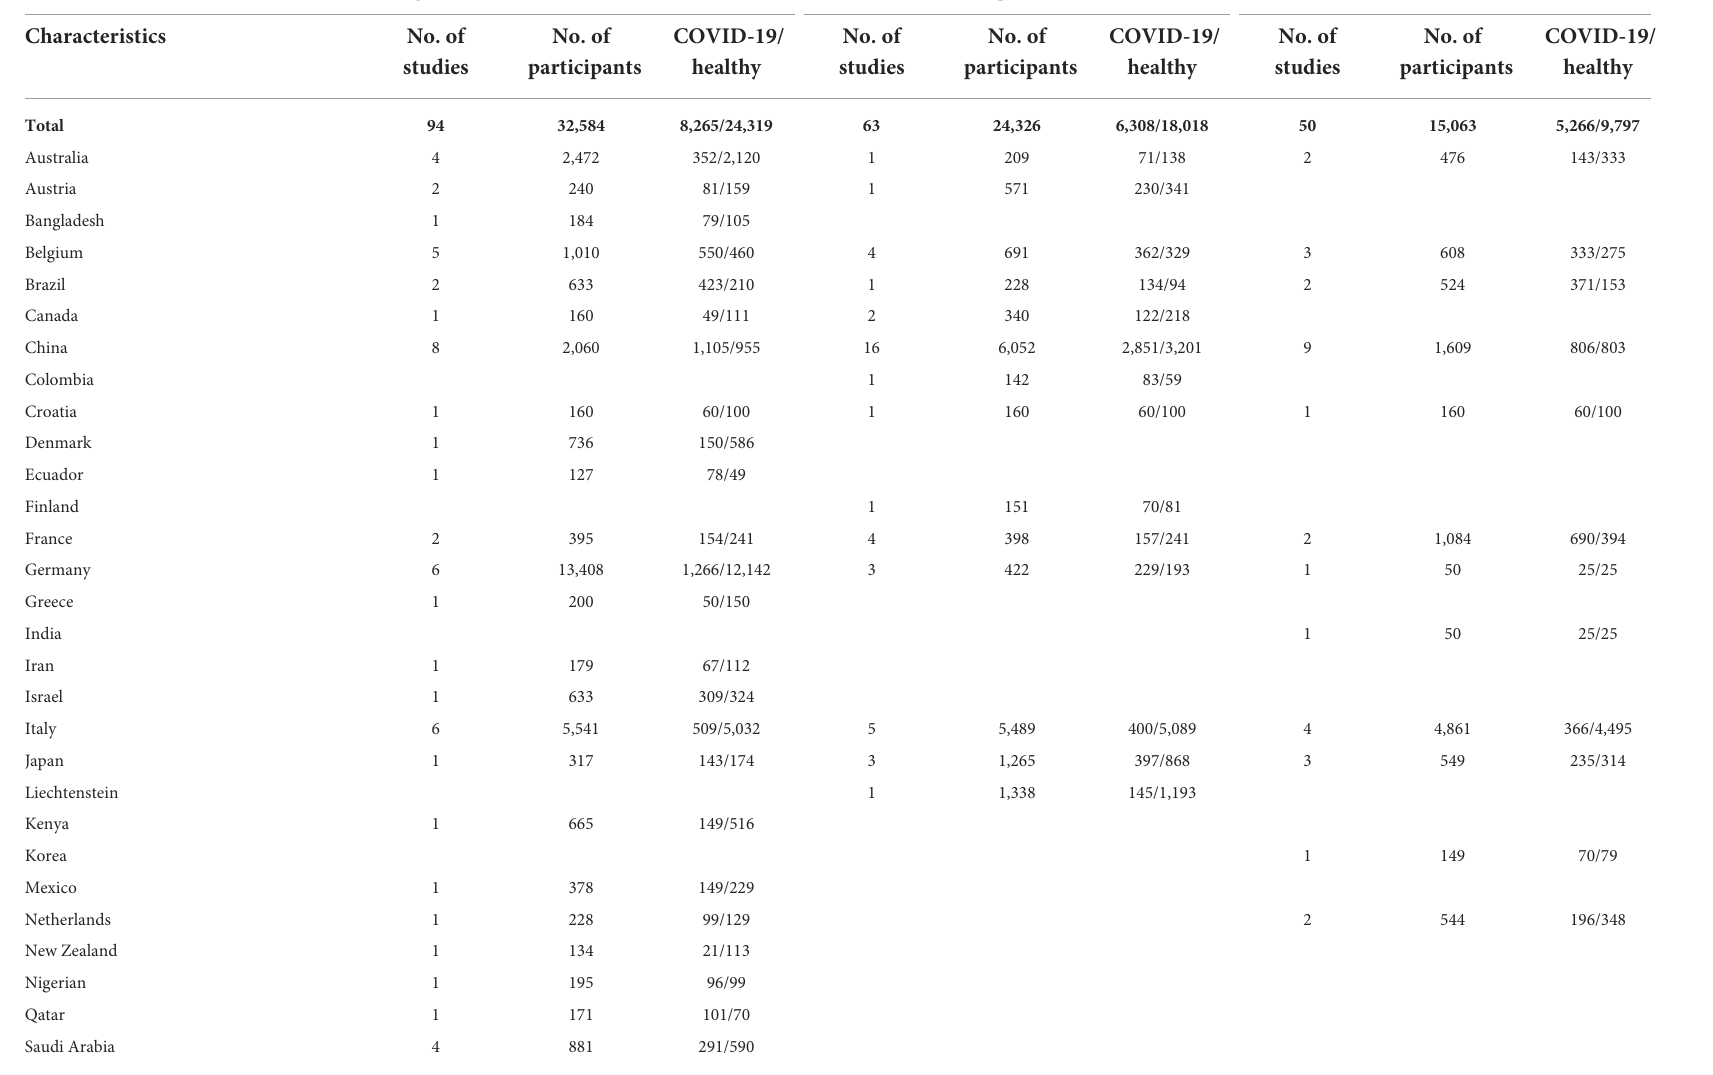
TABLE 1 Summary of characteristics of included studies, stratified by method of serological testing.